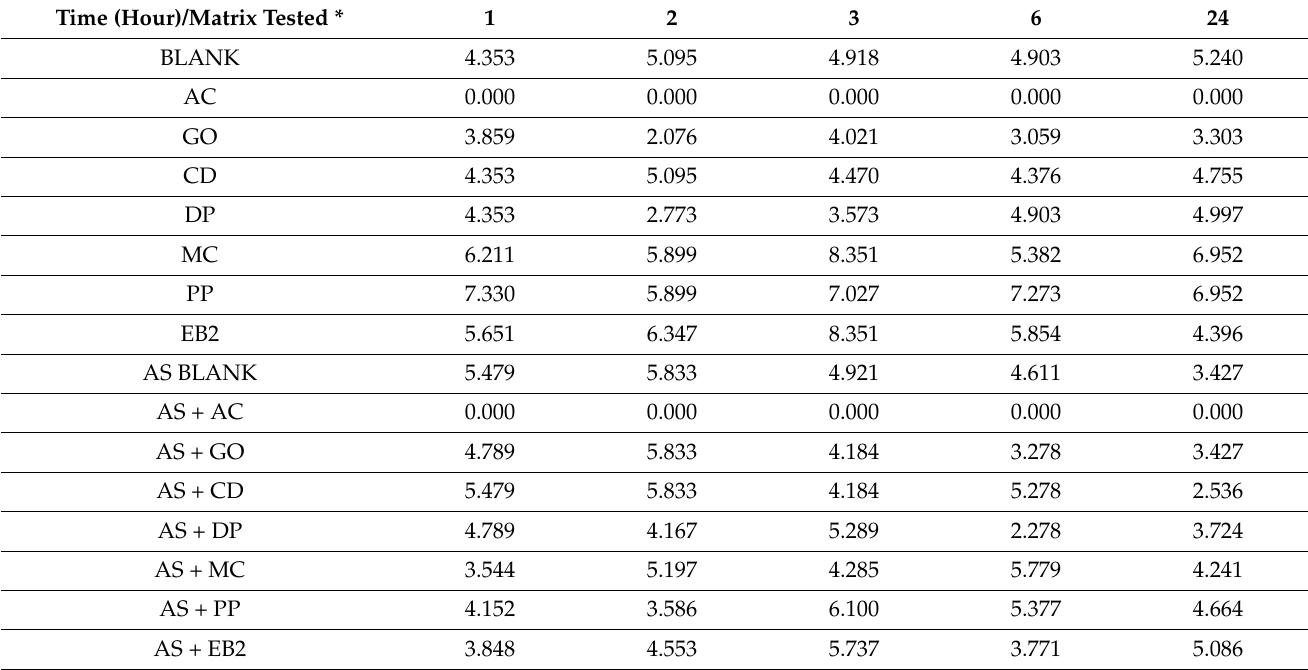
Table 2. Quantitative data of Brilliant Blue concentration (mg L − 1 ) measured in presence of different active matrices during 24 h test (involving activated sludge microorganisms).